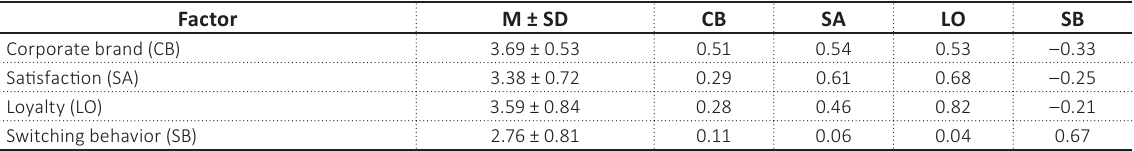
Table 2. AVEs and SICs validity